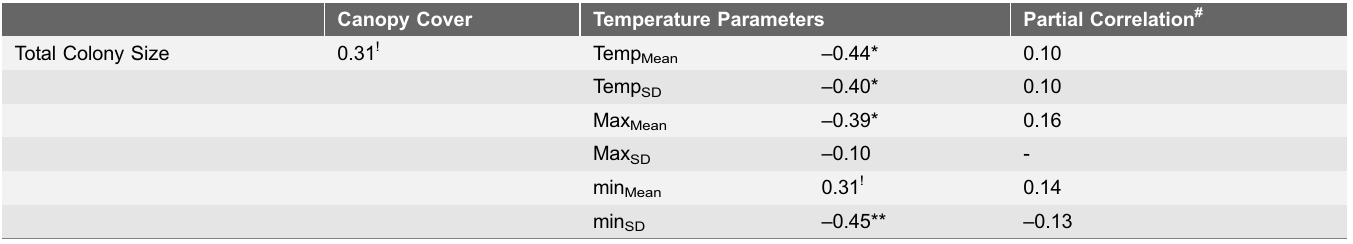
Table 1. Correlations and partial correlations between canopy cover, total colony size and six local temperature parameters (the mean and the standard deviation of hourly temperature, Temp Mean and Temp SD ; the mean and the standard deviation of daily maximum and minimum temperature, Max Mean , Max SD , min Mean , and min SD ).